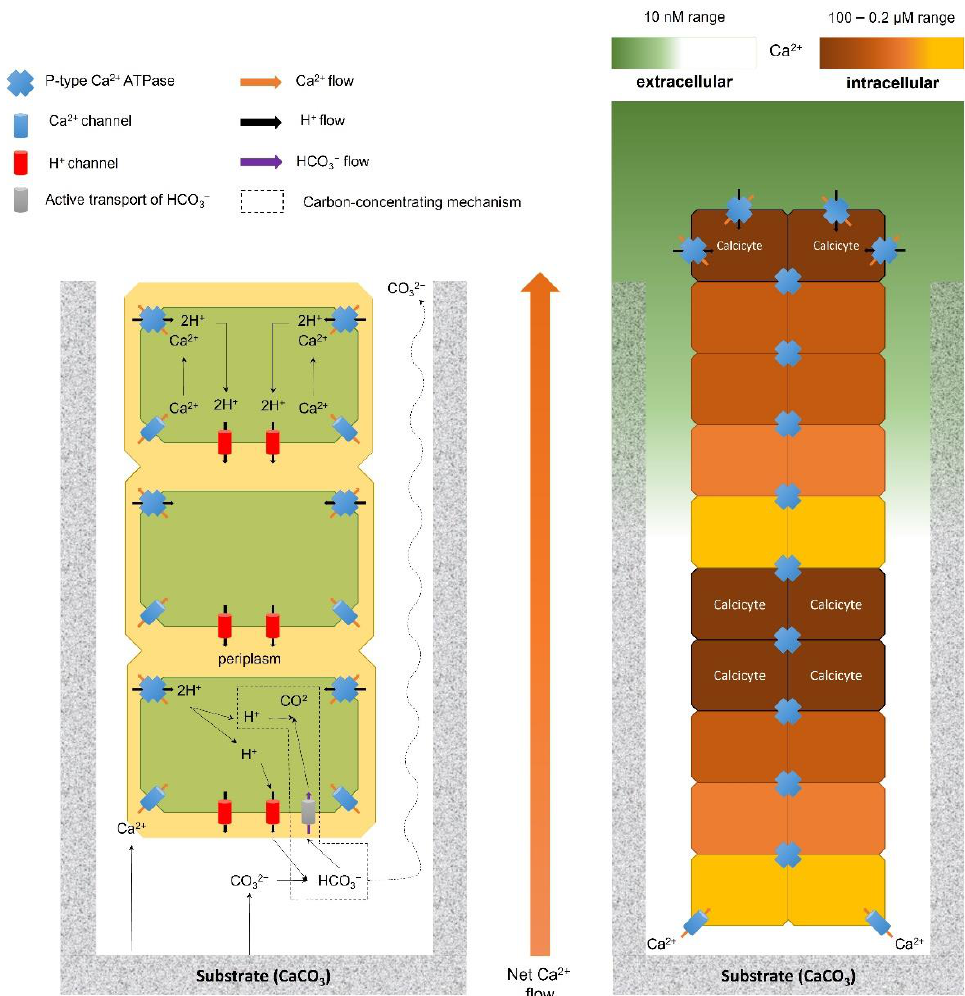
Figure 2. (Right panel). Proposed ’Calcium Pump’ transport mechanism within the trichome of euendolithic cyanobacteria (both filamentous and pseudofilamentous), with the inferred distributions of transporter components (legend in the upper left corner) and the potential fates of the calcite dissolution products (Ca 2+ and CO 32 − ). The calcium transport unit consists of repeating individual bipolar cells, where one pole is specialized for calcium uptake and the opposite for calcium extrusion. Conversion of carbonate ions CO 32 − released from calcite into HCO 3 − is promoted by the counter-transported protons. This HCO 3 − is then actively transported within the cell, where it is converted into CO 2 through the carbon-concentrating mechanisms and can then be used in photosynthesis [89]. (Left panel) Holistic calcium ion localization during boring, with relative calcium concentrations within each compartment indicated. Calcicytes allow a higher proportion of cells within the trichome to remain photosynthetically active by controlling intrafilamentous calcium flow (modified from [90]).